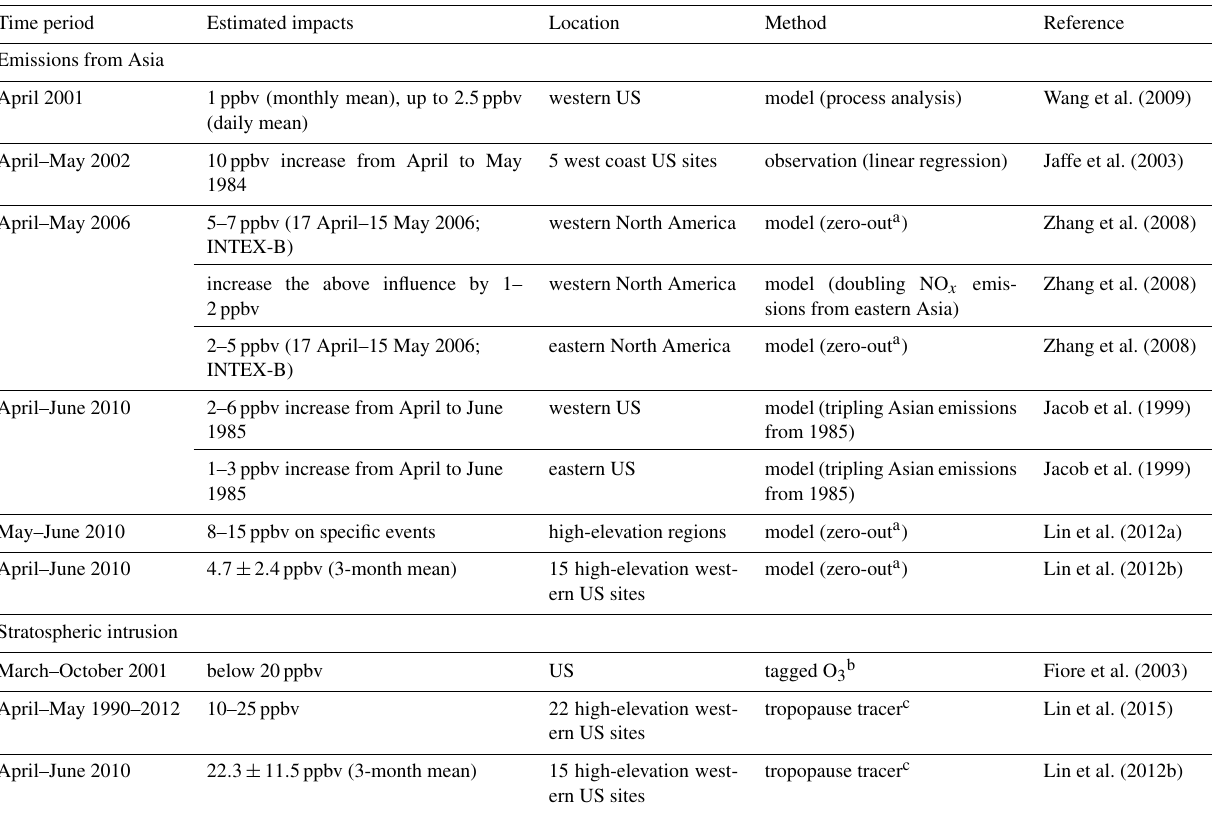
Table 1. Literature review of previous studies on estimated impacts of (upper) emissions from Asia and (lower) stratospheric